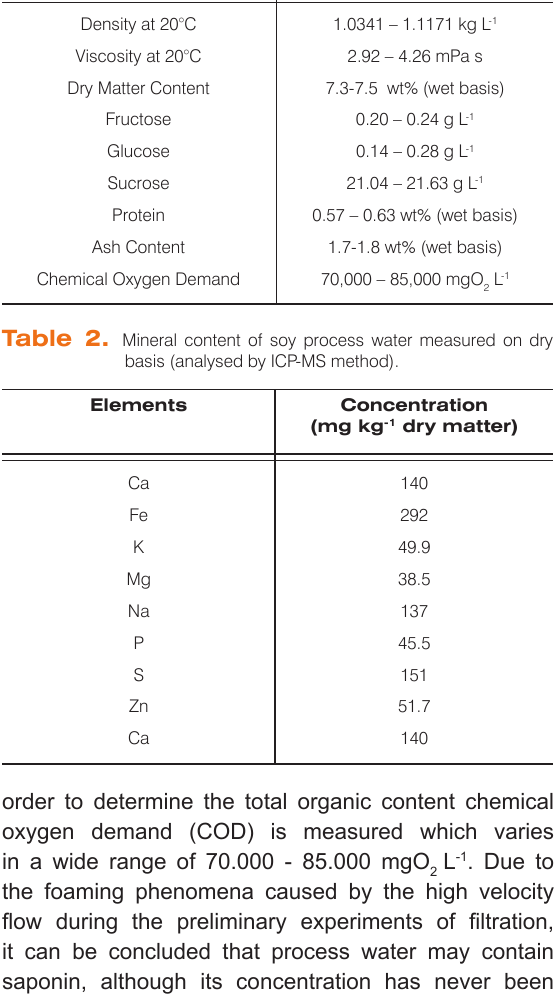
Table 1. Average composition of soy process water. Parameter